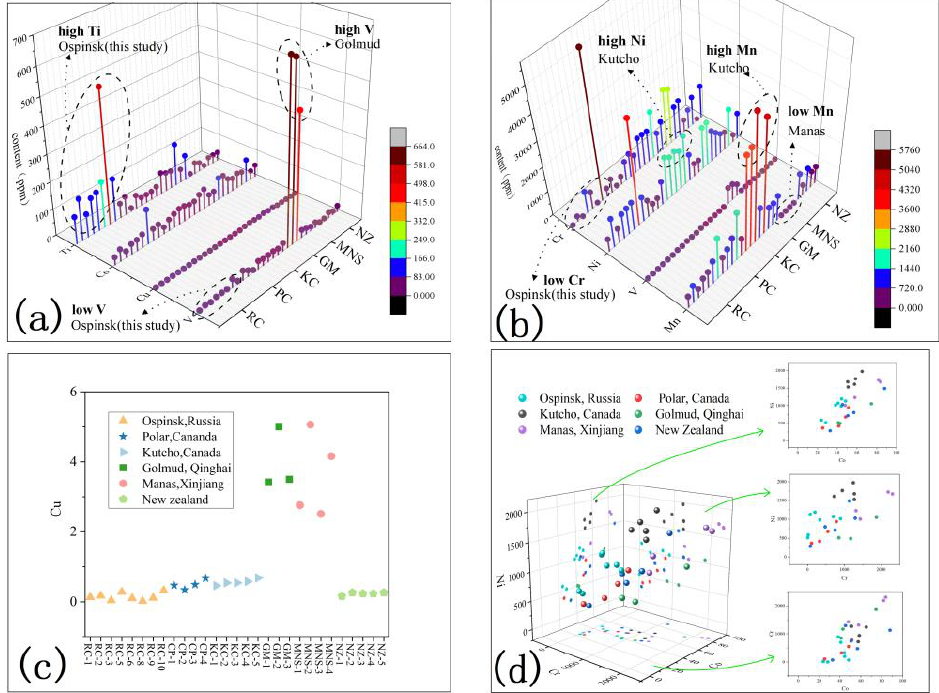
Figure 11. ( a ) Comparison of Ti, Co, Cu and V elements in green nephrite from different areas. ( b ) Comparison of Cr, Ni,V and Mn elements in green nephrite from different areas.( c ) Comparison of Cu element in green nephrite from different areas.( d ) Comparison of Cr – Co – Ni elements in green nephrite from different areas.